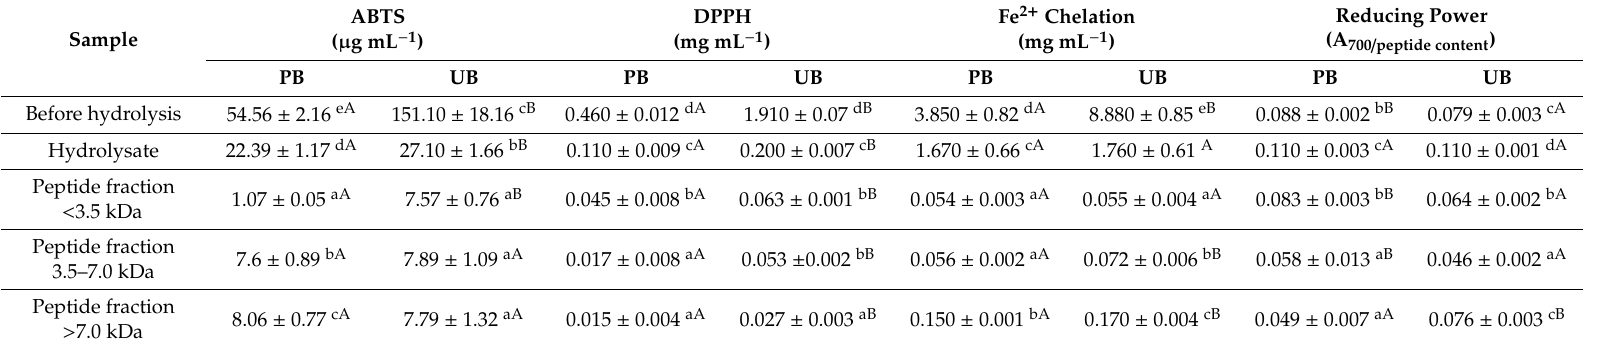
Table 3. Antioxidant activity of samples (IC 50 ).